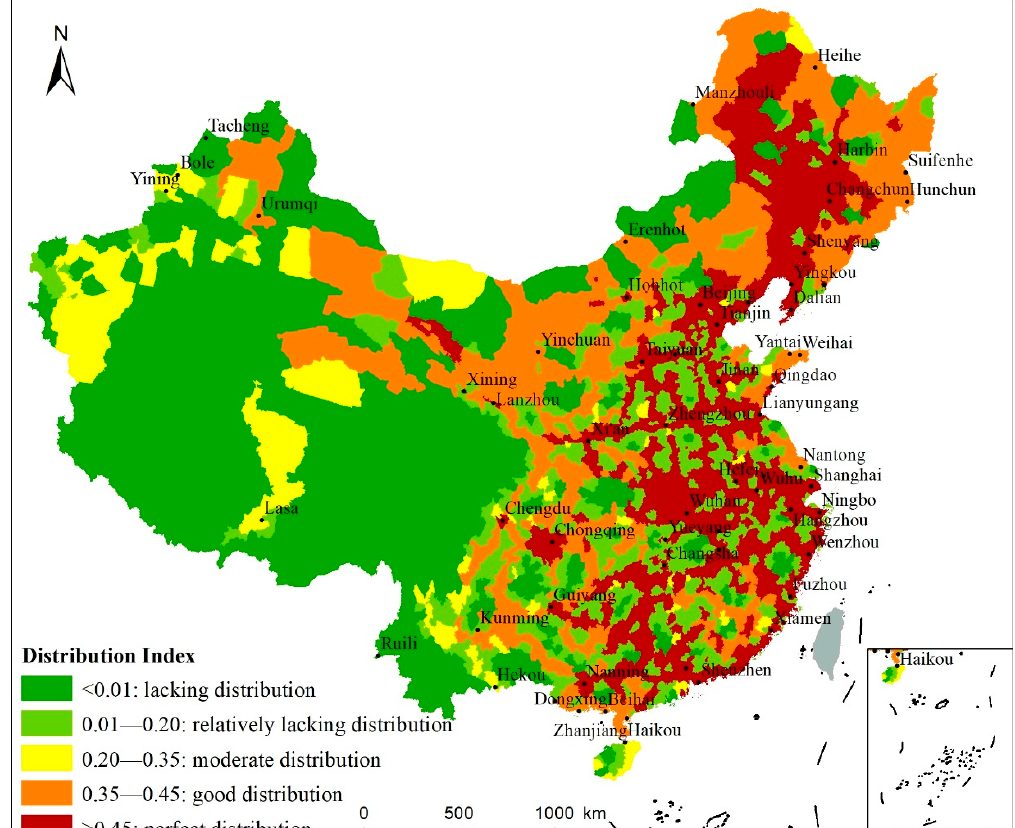
Figure 5. Spatial pattern of the railway network of China in 2015.